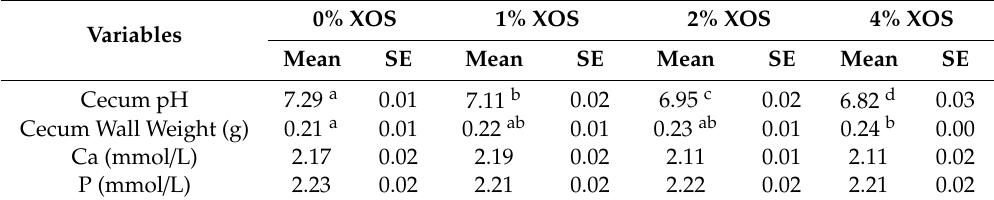
Table 2. Cecum pH, Cecum Wall Weight, and Serum Ca and P Concentrations of 58-d mice fed di ff erent levels of XOS (Mean values and standard errors; n = 8 in each group).